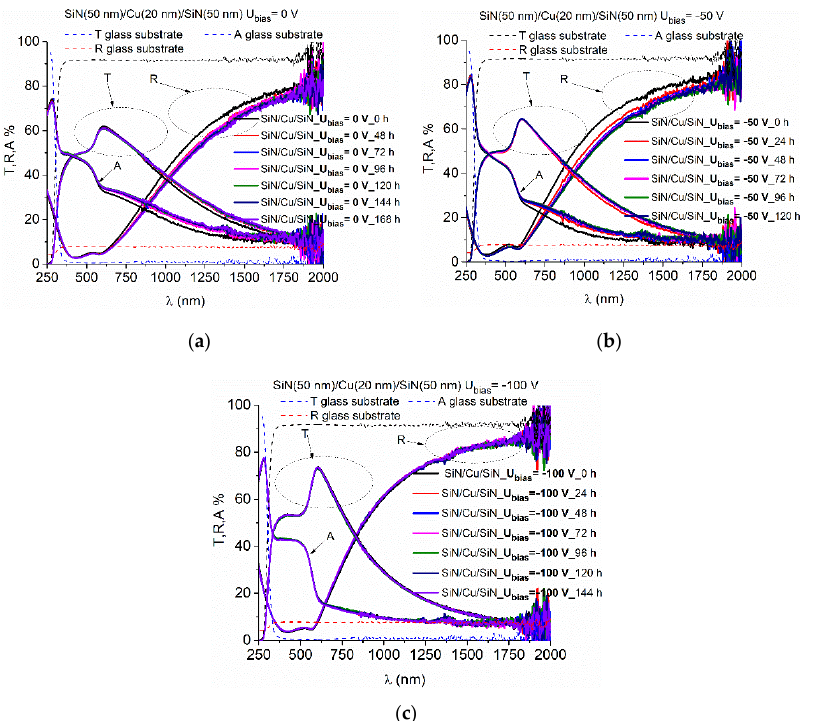
Figure 2. Variation of experimental transmission, reflectance and absorption spectra of multilayer thin films SiN x (50 nm)/Cu(20 nm)/SiN x (50 nm) obtained at different substrate bias voltages: ( a ) 0 V, ( b ) − 50 V, ( c ) − 100 V after exposure to atmospheric pressure conditions.